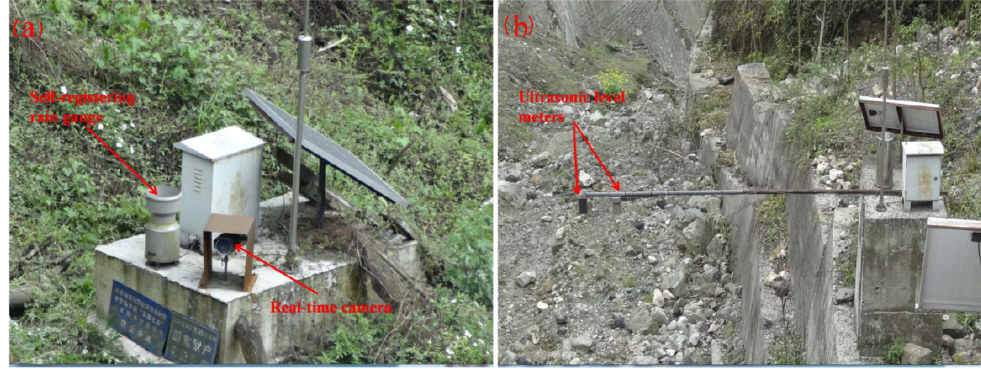
Figure 4. Debris flow monitoring system in the study area.